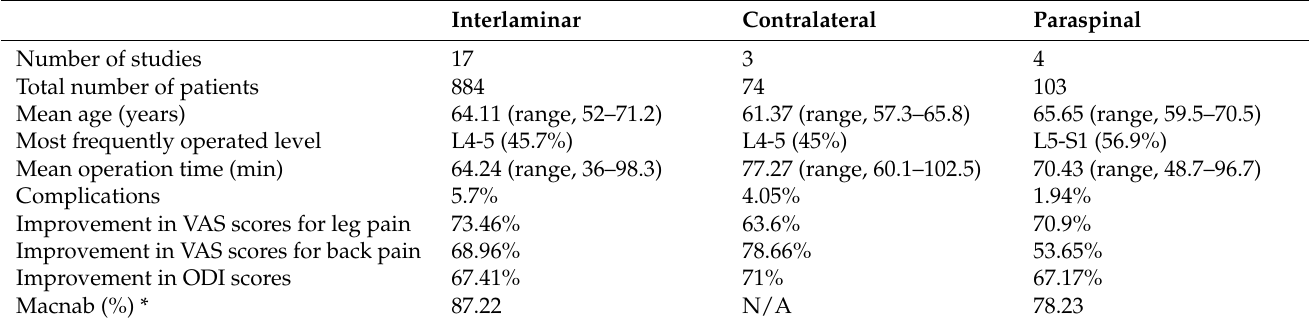
Table 5. A synthesis of three